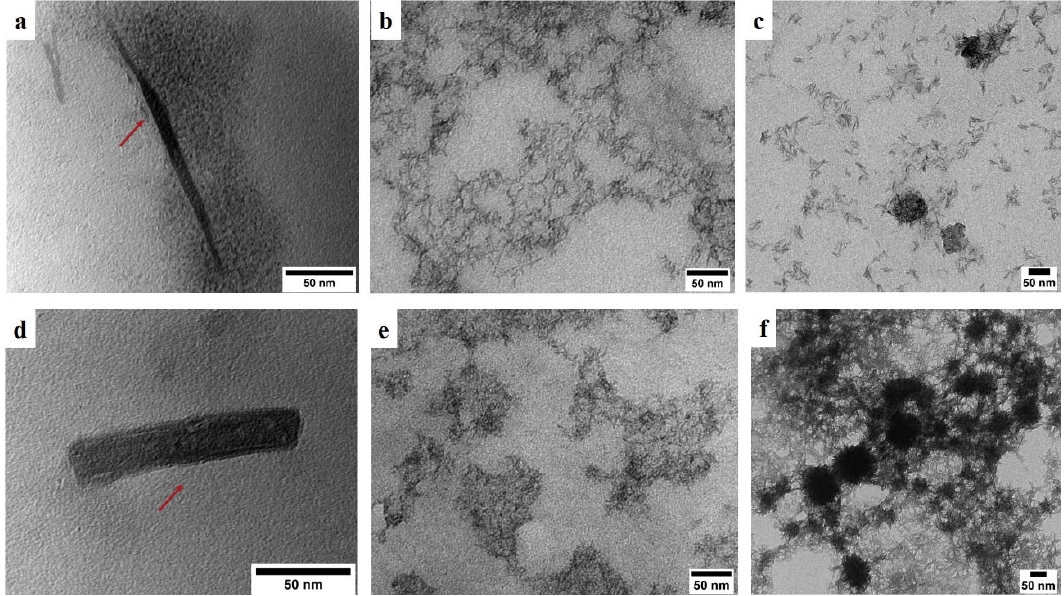
Figure 5. TEM images for ( a ) CNC from sugarcane bagasse (SB ‐ 20), ( b ) the modified SB ‐ 20 A1 ‐ 1, ( c ) Immobilized lipase (Lipase SB ‐ 20 A1 ‐ 1), ( d ) CNC from rice straw (RS ‐ 20), ( e ) the modified RS ‐ 20 B1 ‐ 1, and ( f ) Immobilized lipase (Lipase RS ‐ 20 B1 ‐ 1).